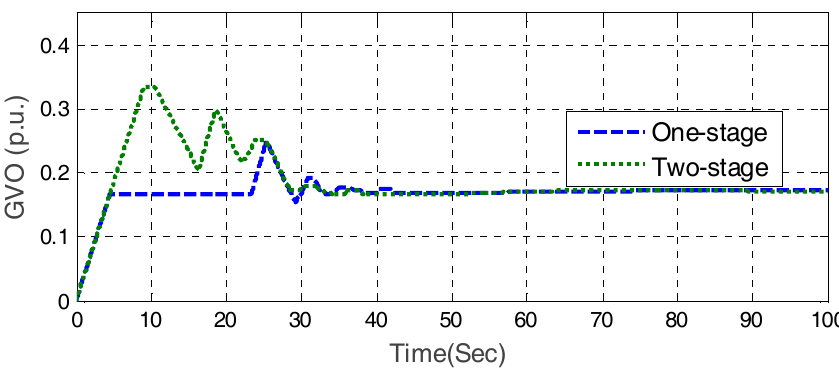
Figure 16. Change process of guide vane opening of traditional start-up strategies with Scheme A. Table 9. Performance indices of traditional start-up strategy of PSU in optimization Scheme A.